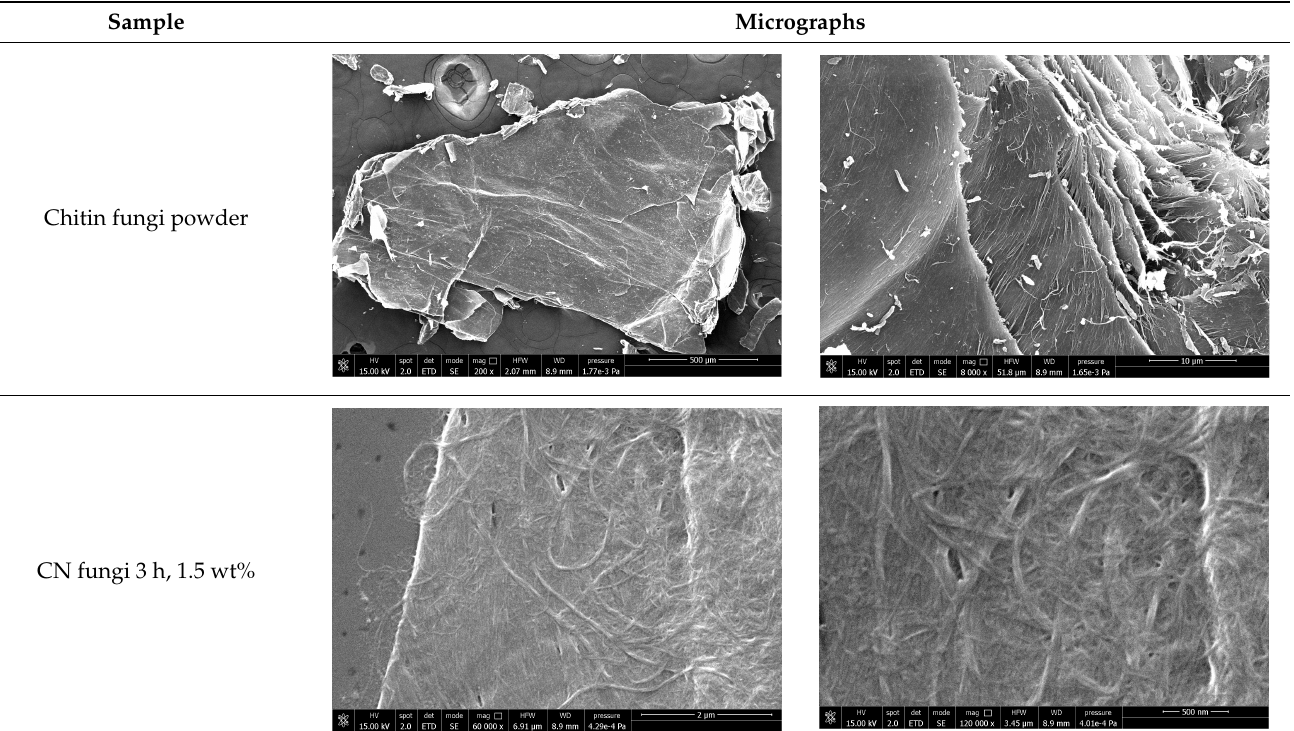
Table 4. Micrographs of chitin suspension from fungi.